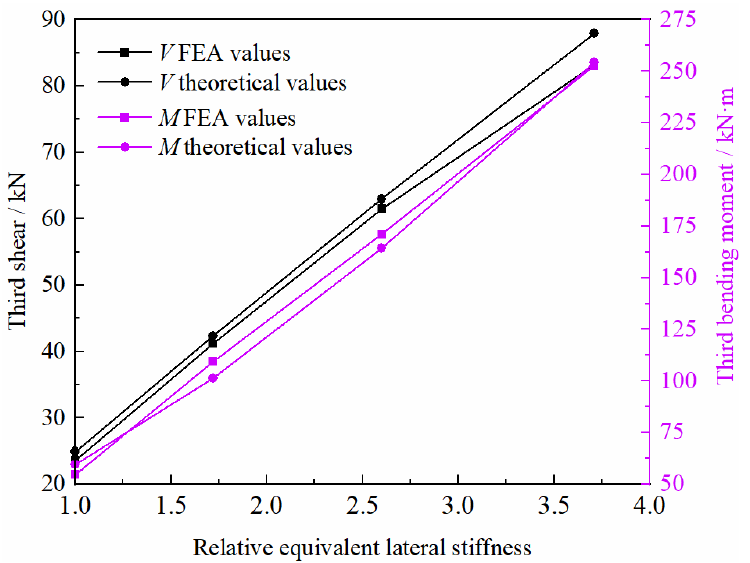
Figure 6. Relationship between the relative equivalent lateral stiffness and third shear and third bending moment. According to Equation (20), the capital level displacement of the side column is the sum of the axial compression deformation of each span caused by the stretching of prestressed steel tendons. As shown in Figure 7, the displacement values are 0.971 mm, 1.746 mm, 2.281 mm and 2.699 mm for single span, double-span, three-span and four